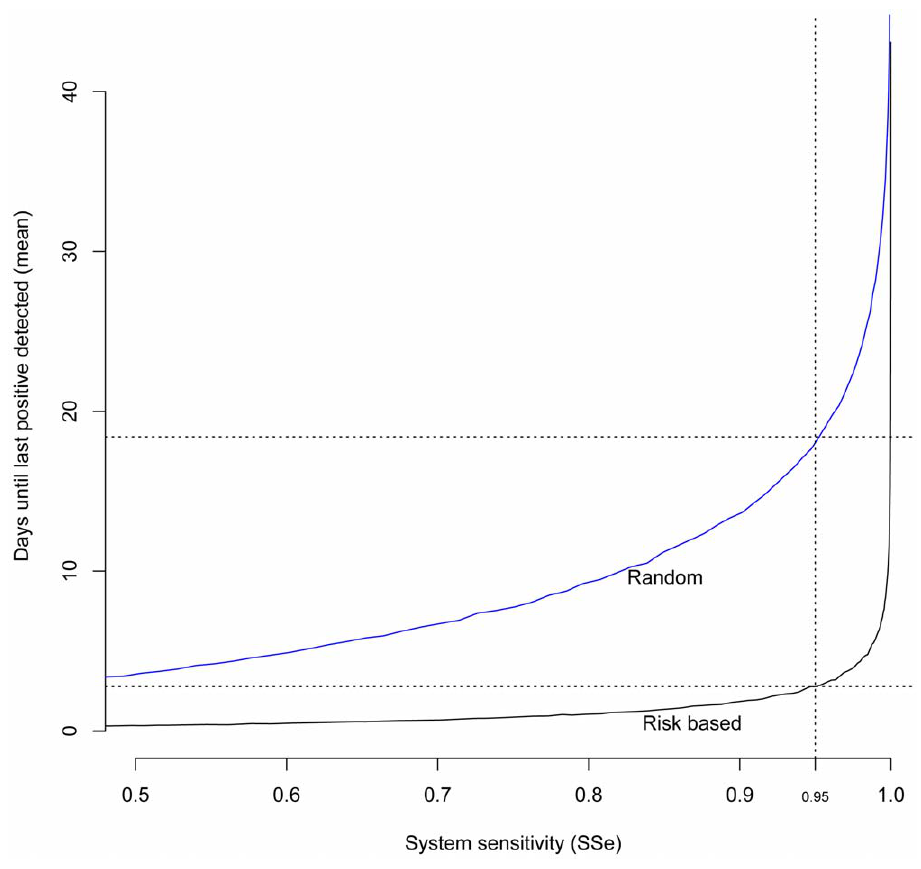
Figure 4. Timing benefits of risk-targeted and ordered sampling. Expected time to last positive farm for randomly selected/ordered (blue) and risk-targeted and ordered sampling (black) shown plotted against system sensitivity (SSe). This analysis assumes that 50 farms are sampled and tested per day.